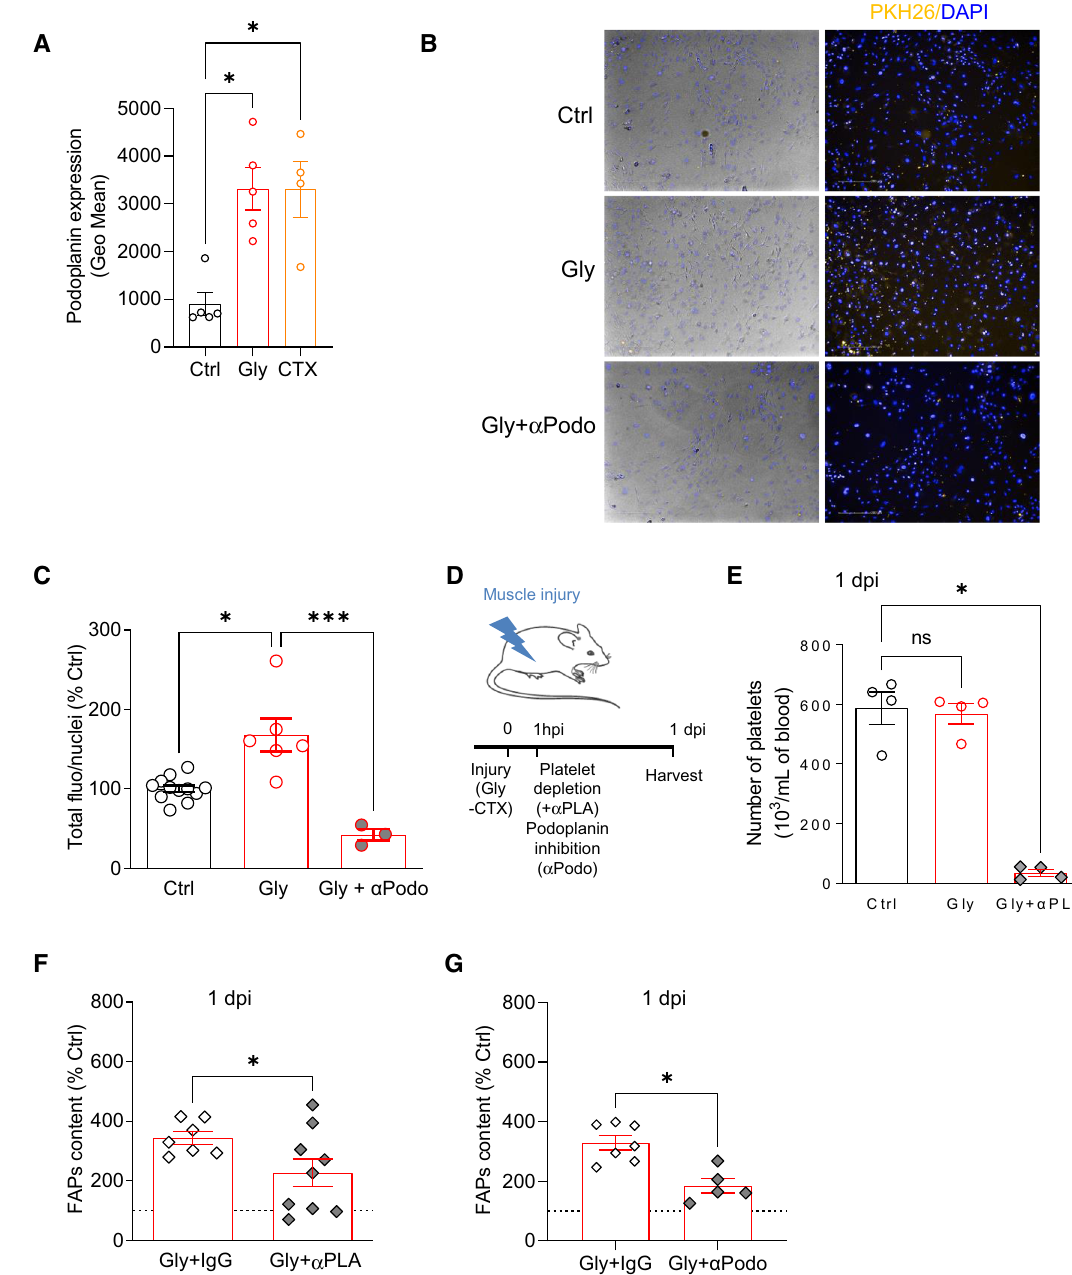
Fig. 5 | The interaction of blood platelets with ASCs determines their in fi ltra- tion into the damaged muscle. A Cell surface podoplanin expression of ScAT- derived ASCs of injured (Gly and CTX) or control animals by fl ow cytometry at 1 dpi. n =5 (Ctrl), 5 (Gly), and 4 (CTX) animals over three independent experiments. B Representative phase contrast and fl uorescent images of PKH26-stained plate- lets (yellow) co-incubated with ScAT-ASCs in the presence or not of blocking podoplanin antibody, bar scale 200 μ m. C Quanti fi cation of PKH26-stained plate- lets with ASCs. n =12 (Ctrl), 6 (Gly), and 3 (Gly+ α Podo) animals over three inde- pendent experiments. D Model of platelet depletion, the fi gure was partly